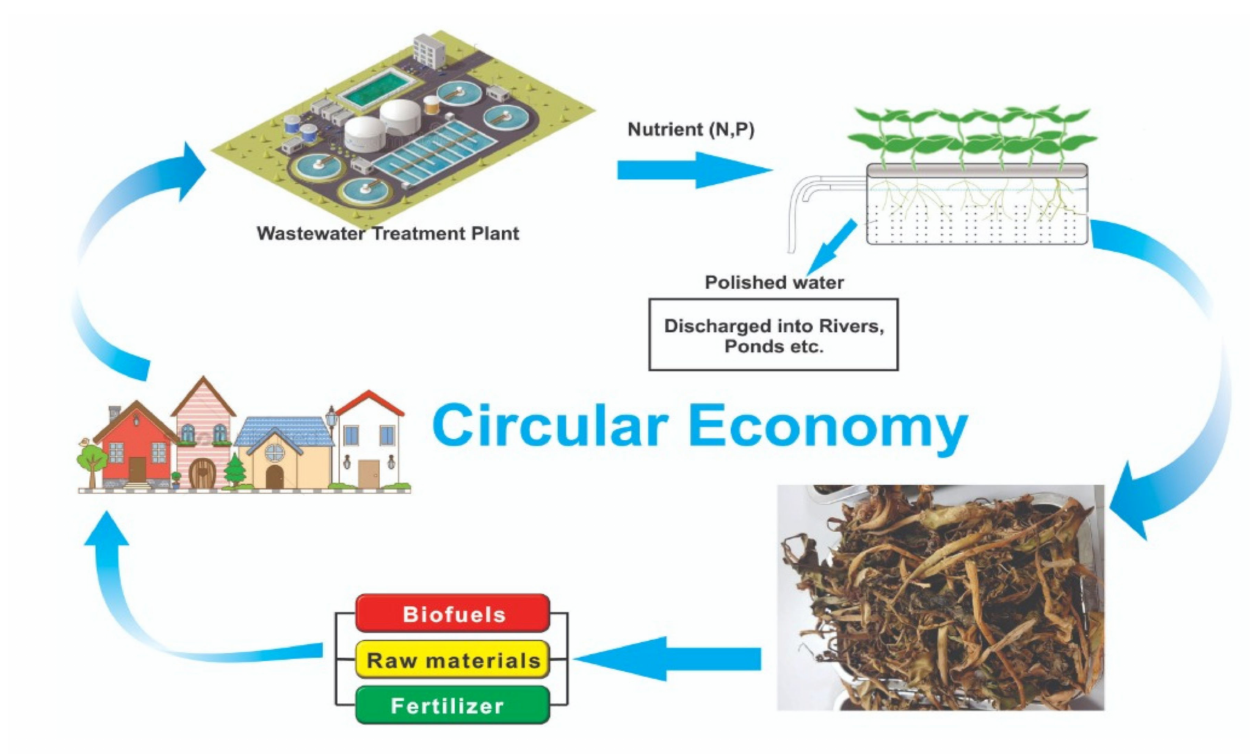
Figure 2. Circular economy model for resource recovery using phytoremediation technology.